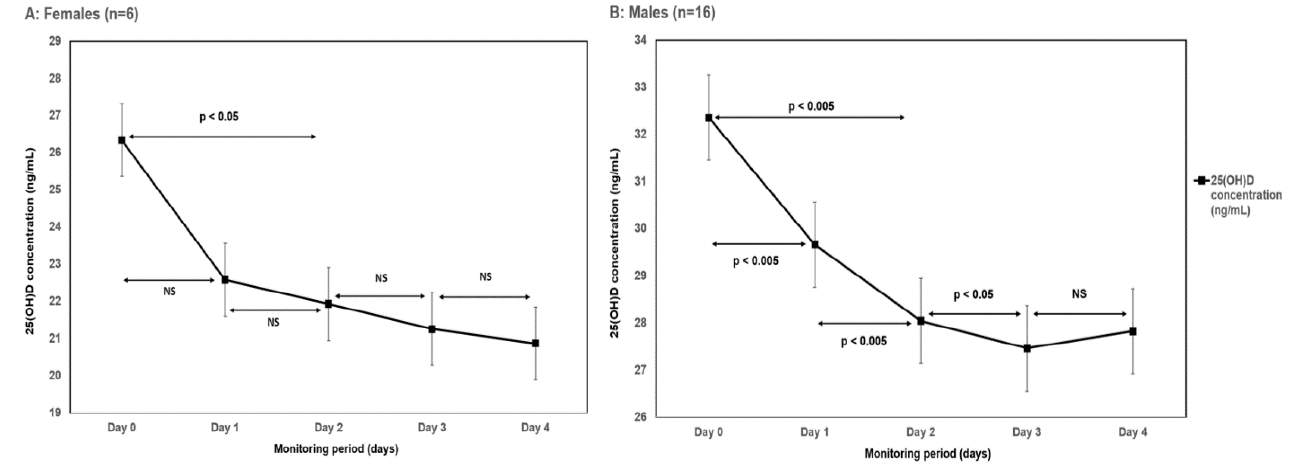
Figure 2. Serum 25-hydroxyvitamin D (25[OH]D) levels kinetics during the study period in females ( A ) and males ( B ), respectively.